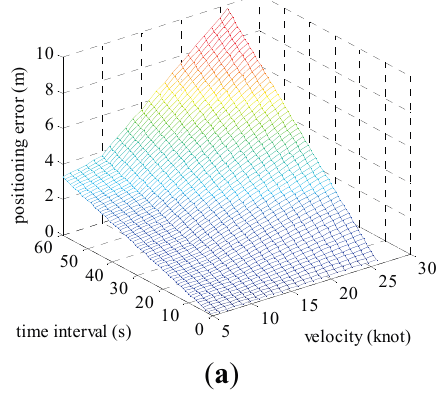
Figure 8. Positioning error influenced by displacement vector. ( a ) Heading error is 0.4°. ( b ) Heading error of